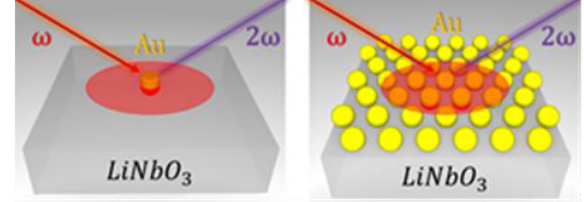
Fig. 2. SHG enhancement by a single gold nanodisc (left) and an array of gold nanospheres from diblock-copolymer micellar lithography (right) on non-linear LiNbO 3 crystals (from